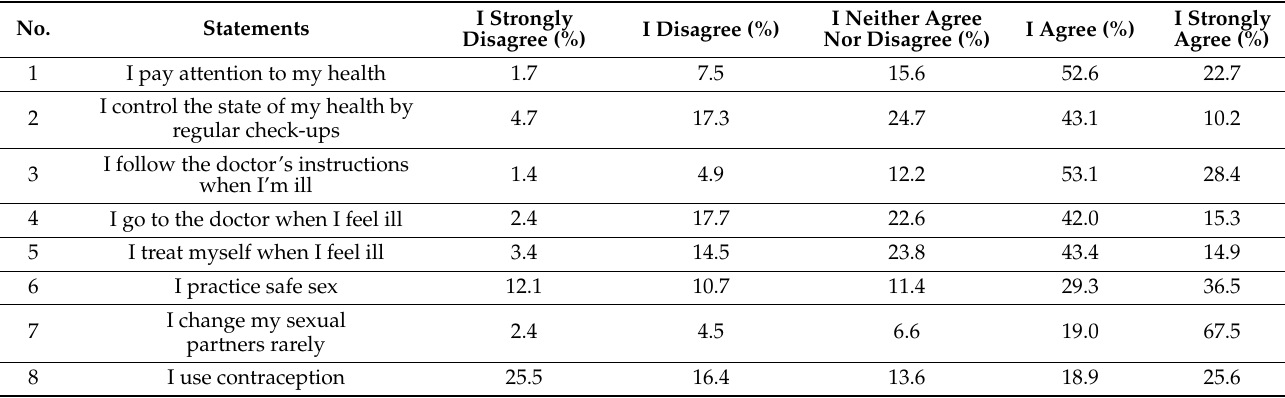
Table 4. Preventive behaviour: self-control of health and self-examination, taking preventive tests, safe behaviour in everyday life, safe sex.